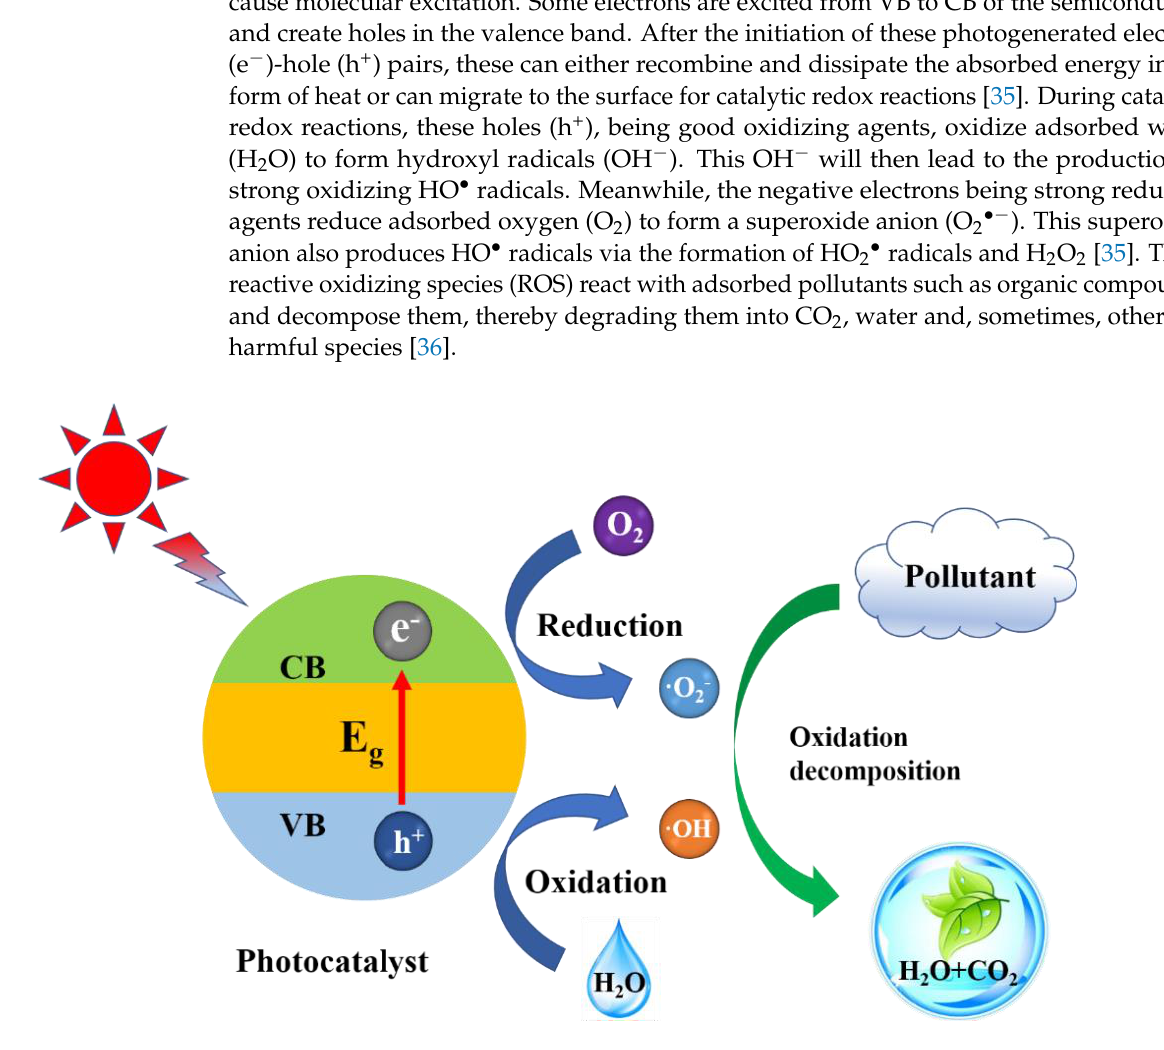
Figure 2. The schematic mechanism of heterogeneous photocatalysis.